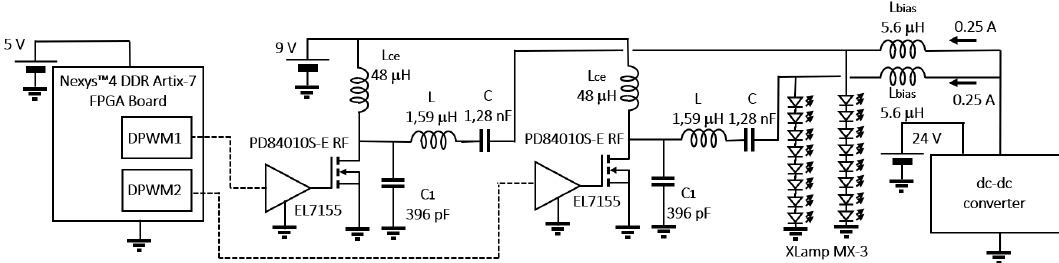
Figure 11. Experimental setup of the adaptation of the Outphasing technique using two Class E RFPAs.